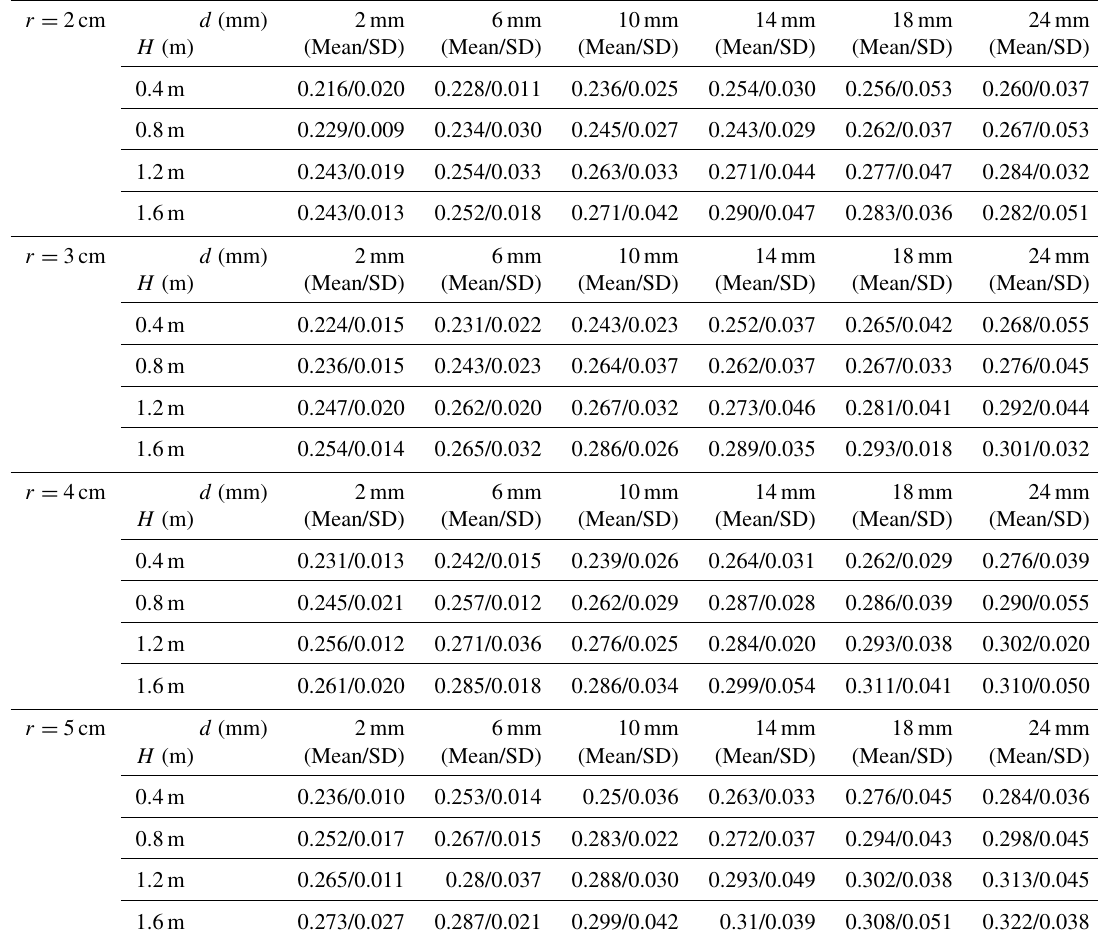
Table 3. Experimental results for the second group of tests (cushion thickness h = 8cm).